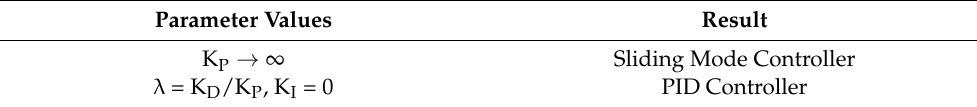
Table 1. PBSMC Behaviors According to Parameters.